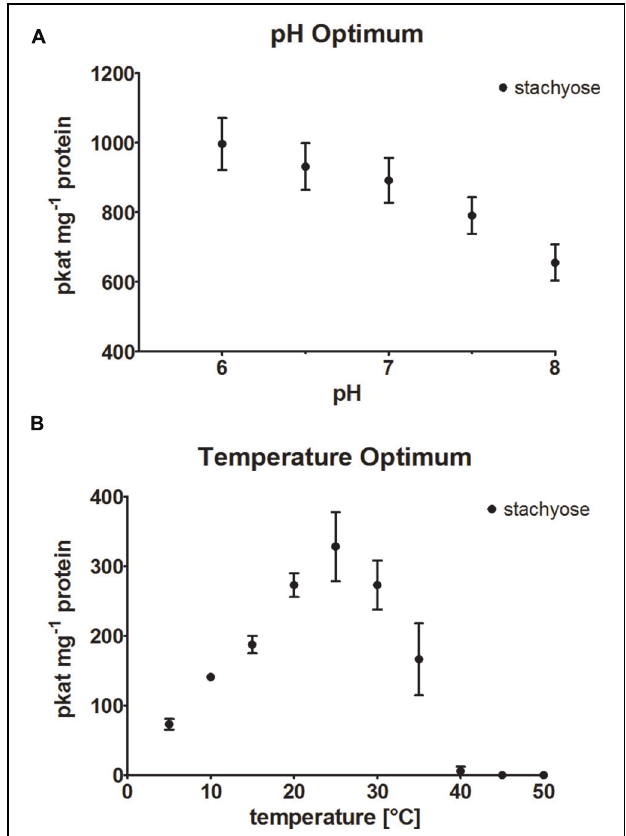
FIGURE 7 | Raf and Sta synthesis of recombinant AtRS4. The effect of different Suc to Gol substrate concentrations ratios on the Raf to Sta product formation ratio of recombinant AtRS4 was tested. (A) Suc in a substrate range from 50 μ M to 100 mM was incubated for 6 h with 1 mM Gol concentration and (B) Gol in a substrate range from 50 μ M to 100 mM was incubated for 6 h with 1 mM Suc and measured with HPAEC-PAD enzyme assays. Raf and Sta concentration was determined using HPAEC-PAD enzyme assay. Values are averages of three independently performed assays ( ±